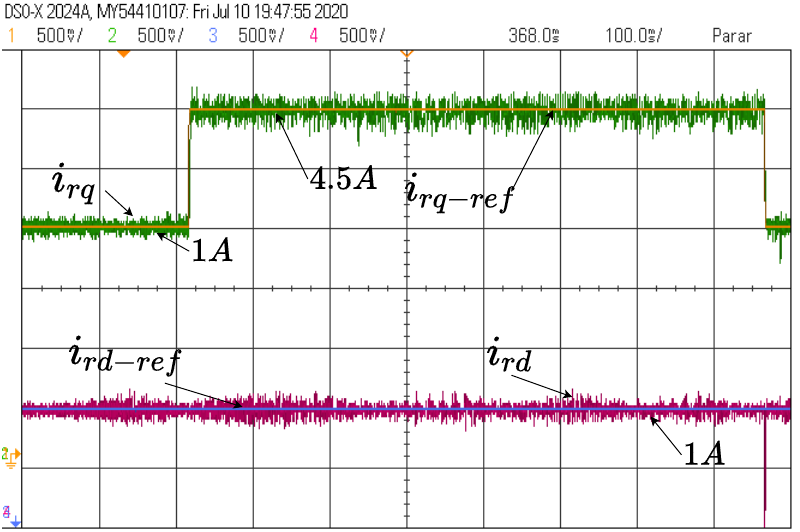
Figure 9. Controller operation closer to the rated power of the DFIG.